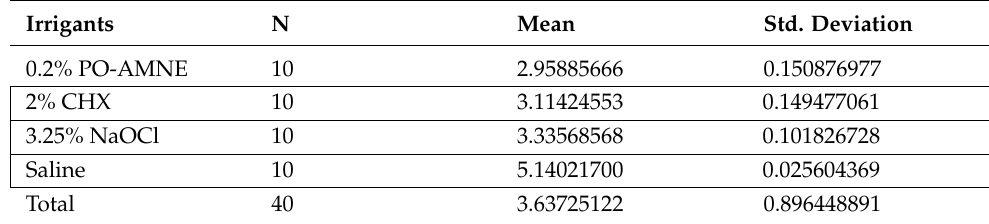
Table 12. Mean and standard deviation of irrigants against C. albicans at 400 µ m.